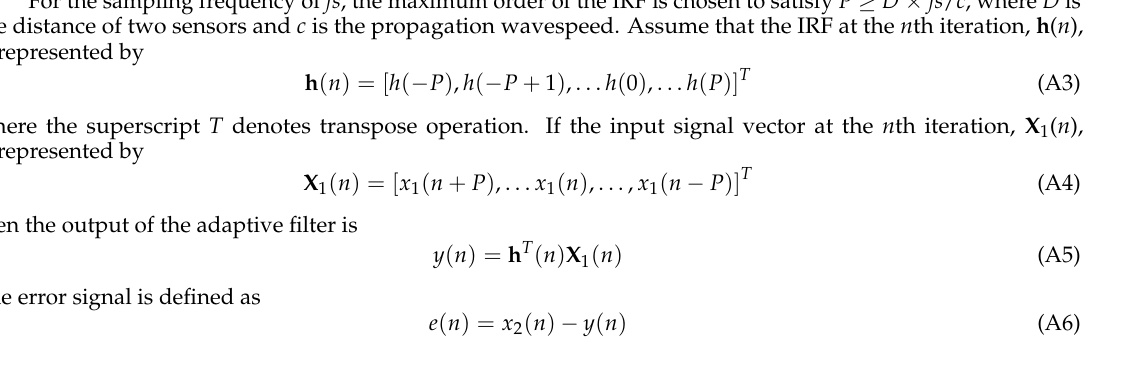
Figure A1. Schematic of the implementation of the LMS adaptive method.